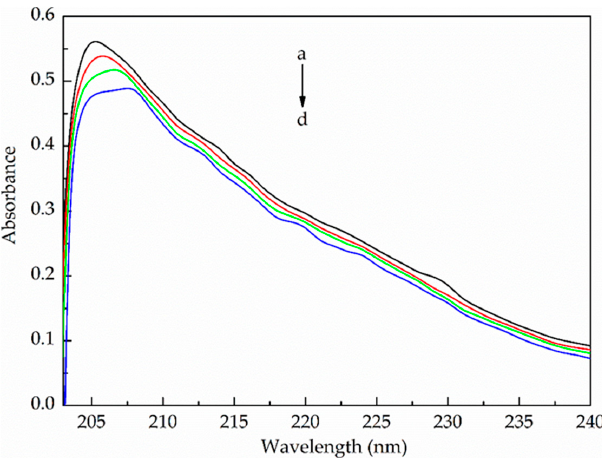
Figure 5. UV-Vis spectra of CAT with different concentrations of 2-MT (versus the same concentration of 2-MT solution). Conditions: CAT: 1.0 × 10 − 7 mol·L − 1 ; 2-MT: 0 mol·L − 1 (a); 1 × 10 − 5 mol·L − 1 (b); 2 × 10 − 5 mol·L − 1 (c); 3 × 10 − 5 mol·L − 1 (d); pH 7.4; T = 291 K.